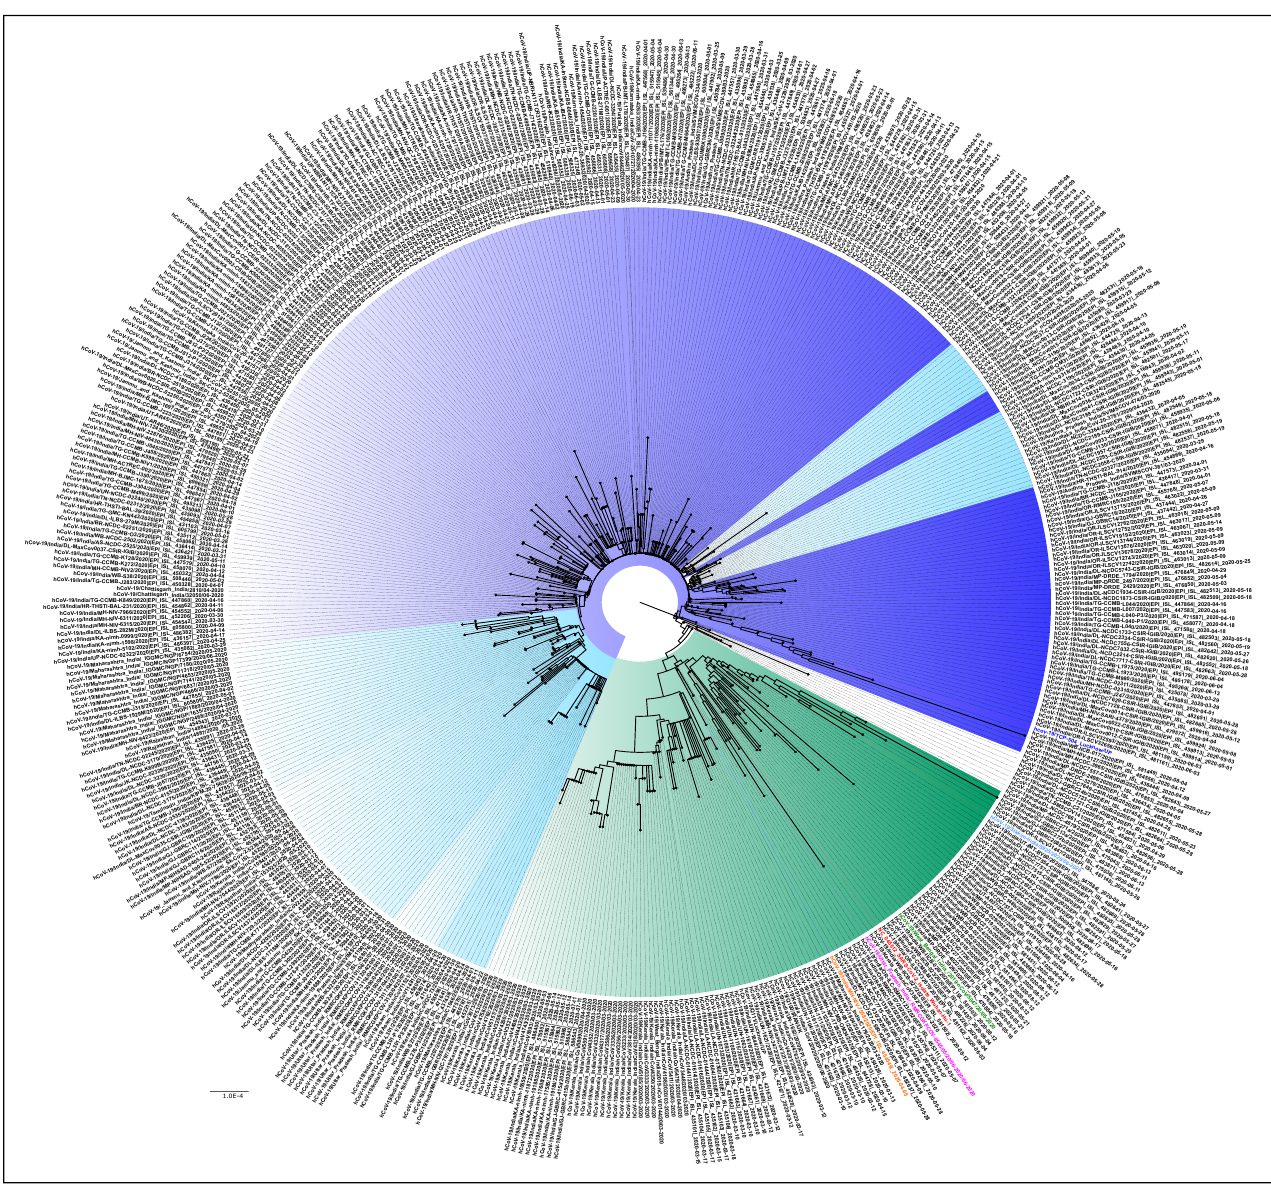
Figure 3. Phylogenetic tree of the 406 unclassified SARS-CoV-2 genomes: A Neighbor-joining tree of the 406 unclassified SARS-CoV-2 sequences retrieved in this study, along with the representative SARS-Cov-2 sequences from different clades with a bootstrap replication of 1000 cycles. Two major groups of unclassified sequences were observed, which are marked in different shades of blue and green. The first cluster has amino acid changes at ORF1ab (T2016K, A4489V) and N: P13L, represented in blue and its shades, whereas the second cluster has amino acid changes at ORF1ab (R207C, V378I, and M2790I), represented with the green color edges. The representative L, S, V, G, GH, GR GISAID clades are marked on the nodes with the colors red, pink, orange, green, blue, and light blue, respectively. FigTree v1.4.4 was used to visualize the generated